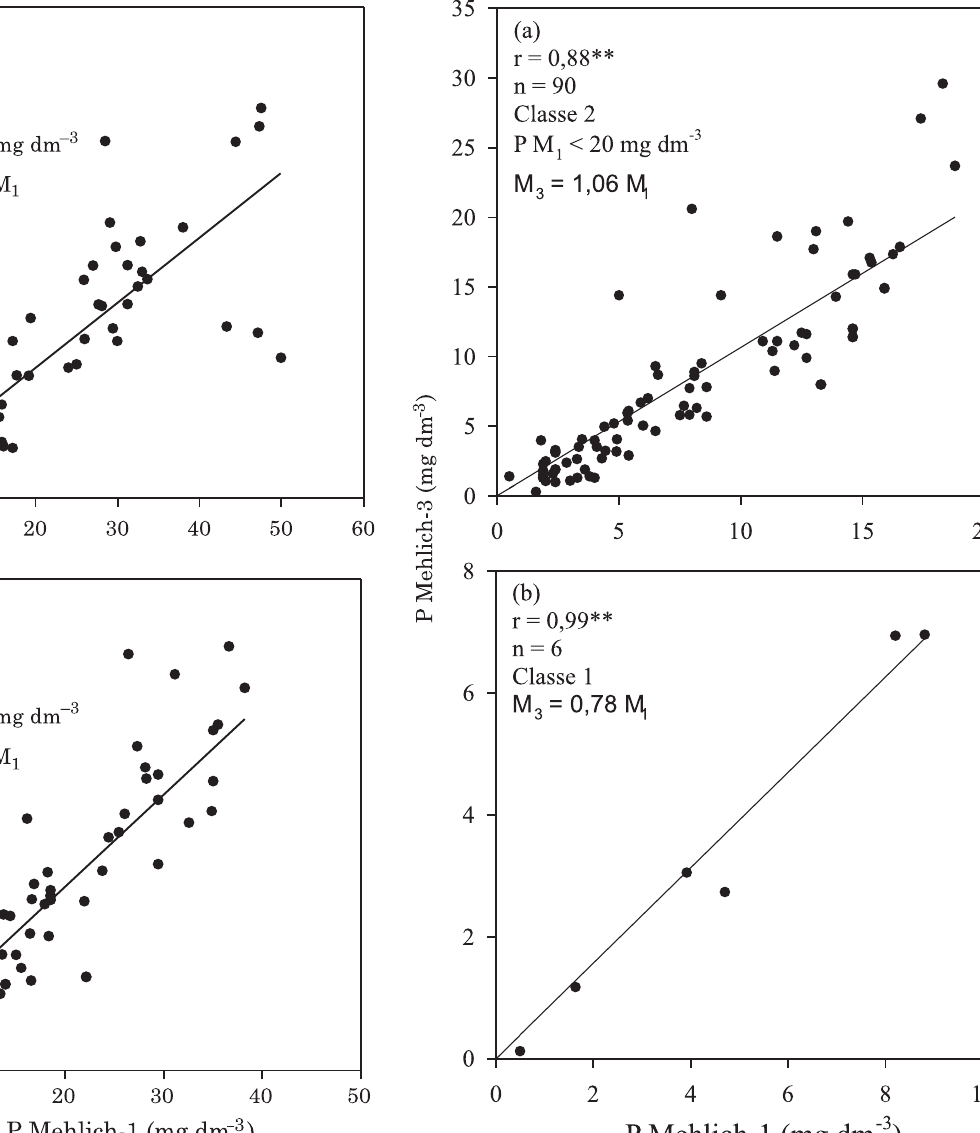
Figura 3. Correlações entre os teores de P extraído pelas soluções de Mehlich-1 e de Mehlich-3, para solos com teores de argila entre 410 e 600 g dm -3 (Classe 2) (a) e > 600 g dm -3 (Classe 1)